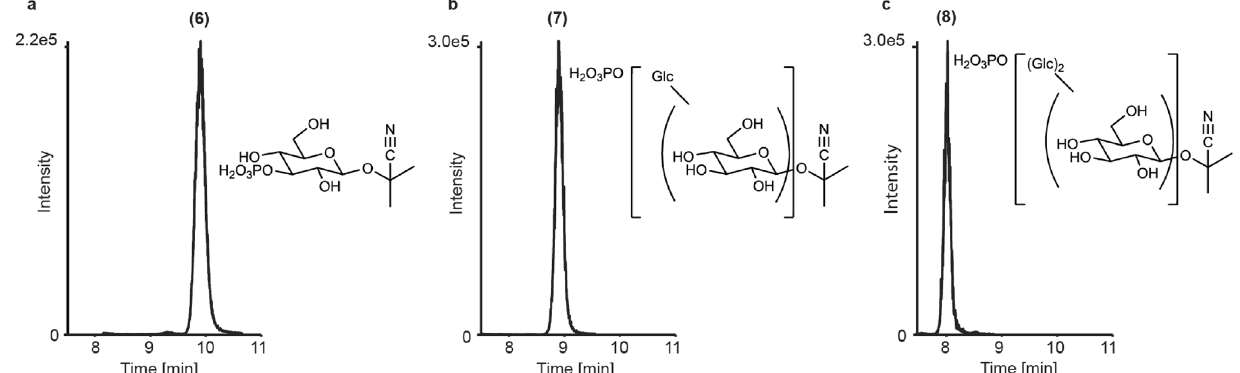
Figure 3. Novel phosphorylated linamarin derivatives in B. tabaci honeydew. Linamarin and the whitefly- produced linamarin glycosides were also phosphorylated by B. tabaci . ( a ) The position for phosphorylation of linamarin was elucidated as C3 ( 6 ) by NMR (Supplementary Note 1). The structures of both the monoglucosylated ( 7 , b ) and diglucosylated ( 8 , c ) phosphorylated derivatives were supported by mass spectral data, but NMR analysis was not possible due to low